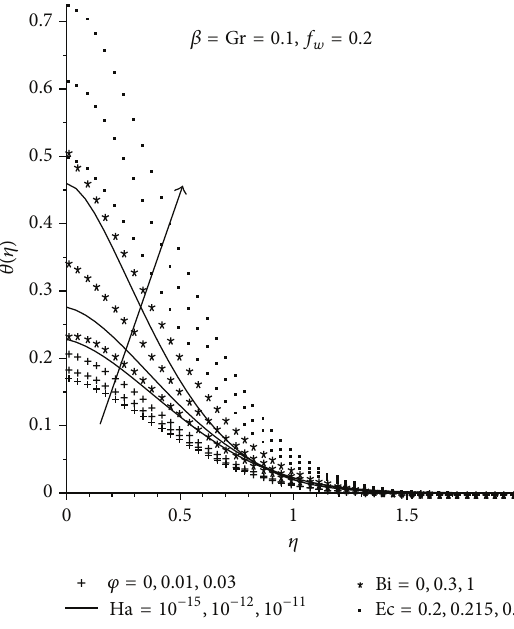
Figure 6: Temperature profiles with increasing 𝜑 , Ha, Bi, and